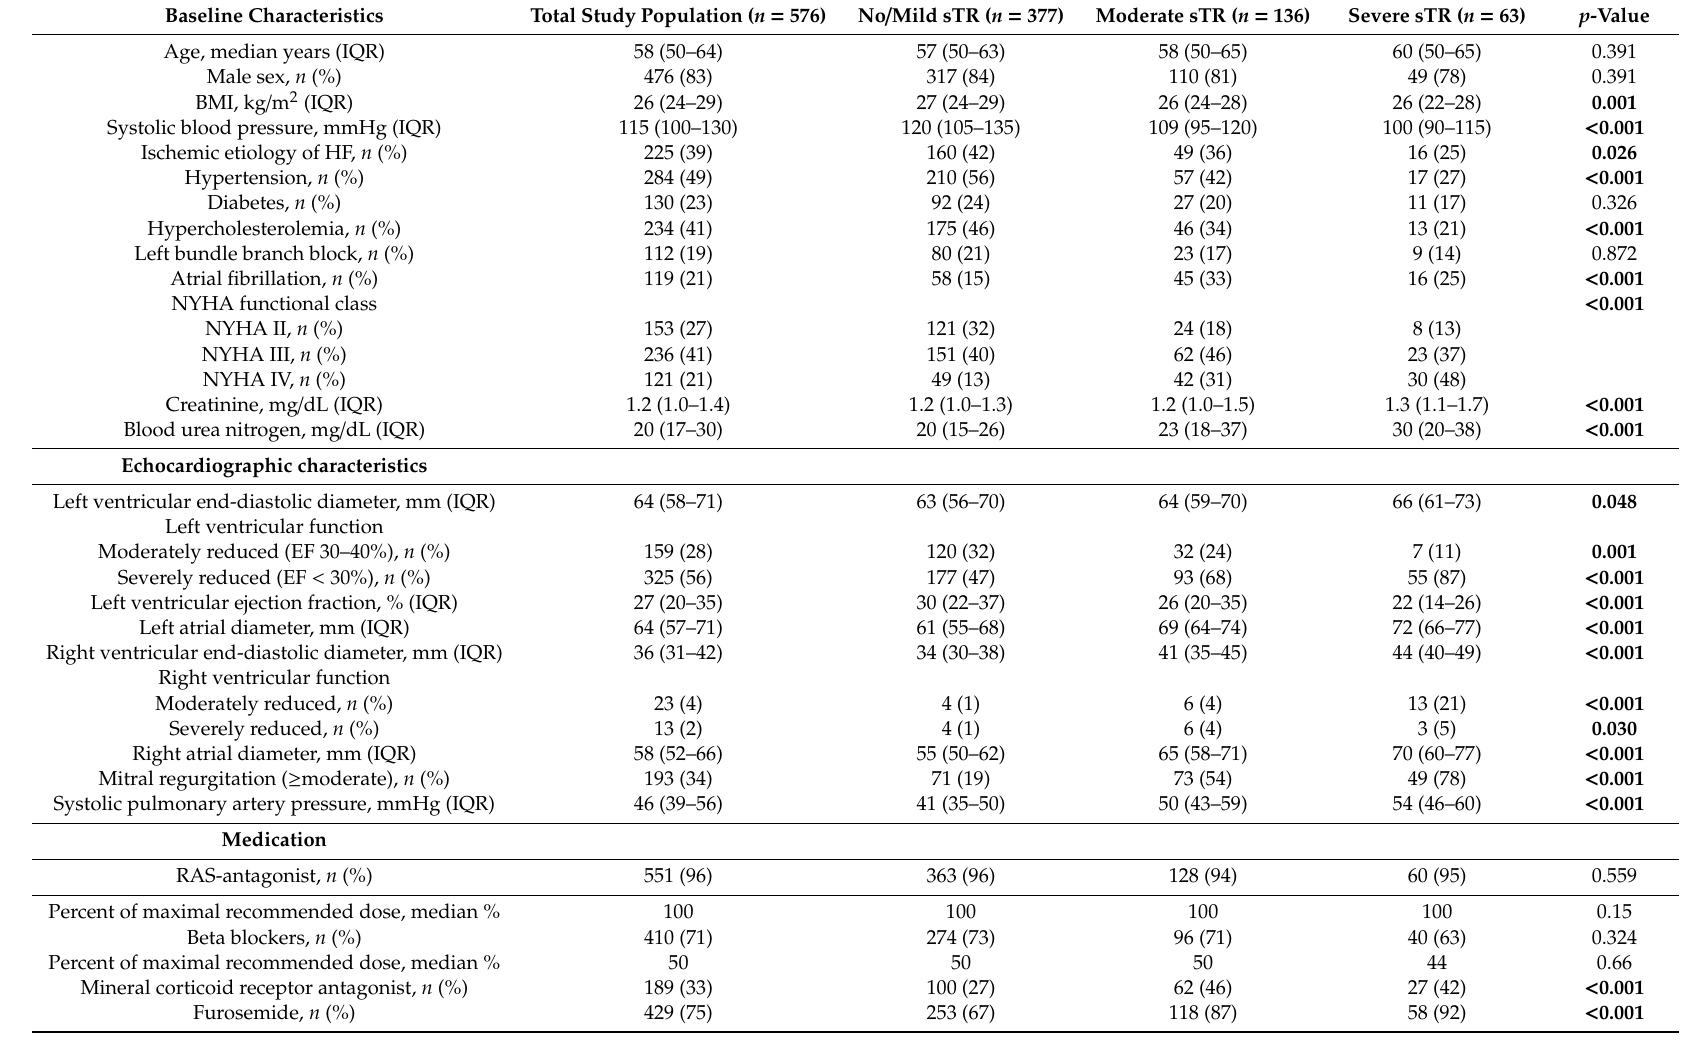
Table 1. Baseline characteristics of the entire study population ( n = 576) according to severity of secondary tricuspid